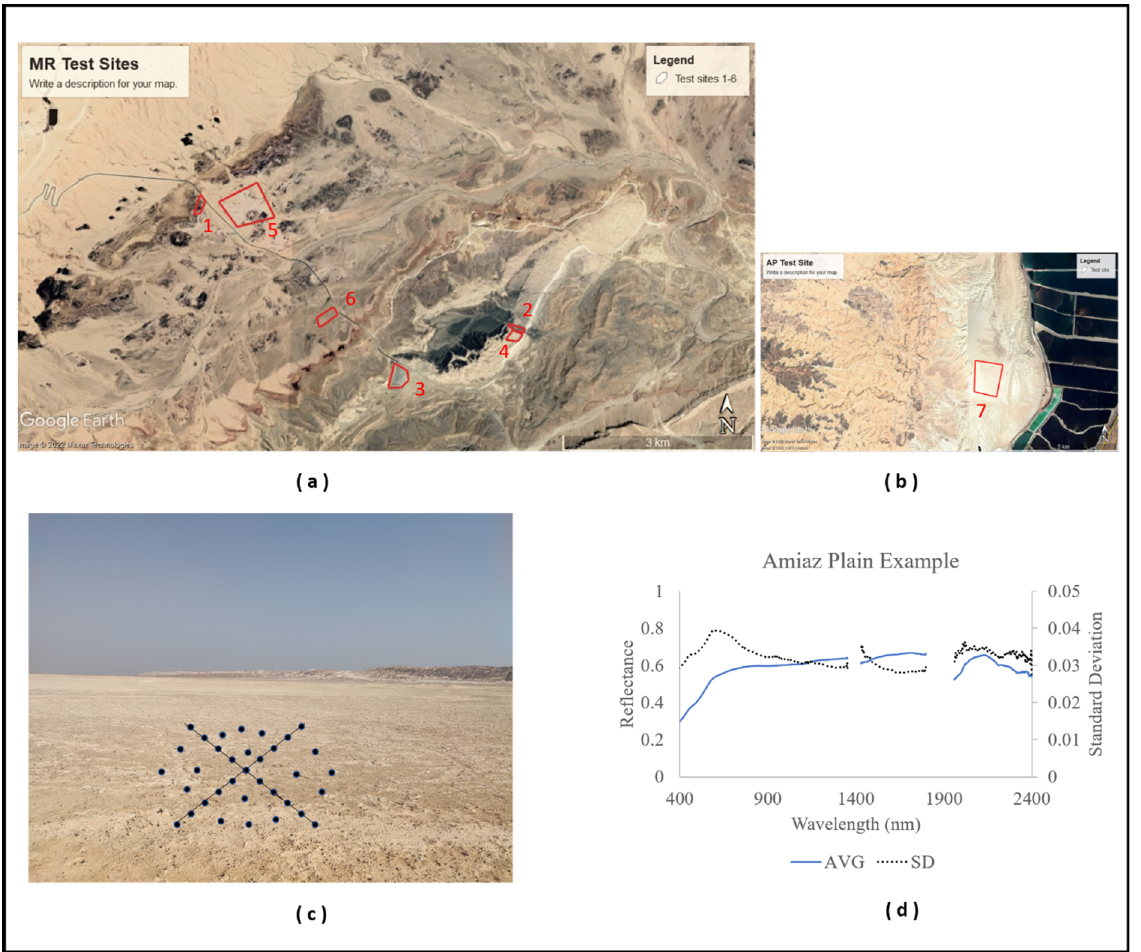
Figure 3. Location of test sites in ( a ) MR, and ( b ) AP. ( c ) Field spectral measurement protocol; example from the AP test site. ( d ) Average spectral signal (AVG, solid blue line) and standard deviation (SD, dashed black line) for AP 30 × 30 cube.